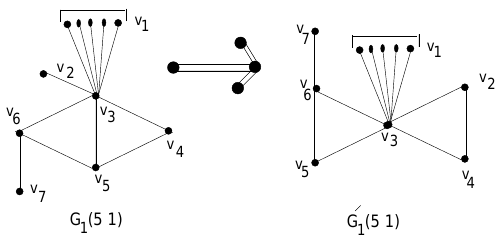
Figure 4: a ( G (cid:48) 1 (5, 1) c ) < a ( G 1 (5, 1) c ).